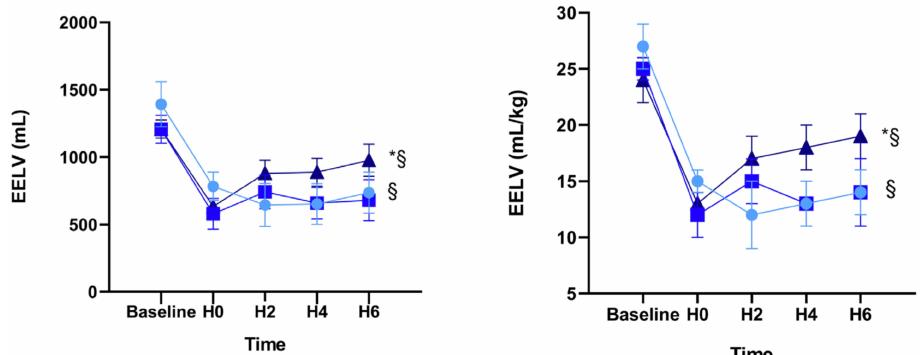
Figure 2. Alterations of end-expiratory lung volume in absolute values and in relation to body weight in response to acute lung injury and intra-abdominal pressure of 10 mmHg over 6 h of mechanical ventilation. • = group A with PEEP: 5 cmH 2 O, (cid:4) = group B with PEEP: 10 cmH 2 O, (cid:78) = group C with